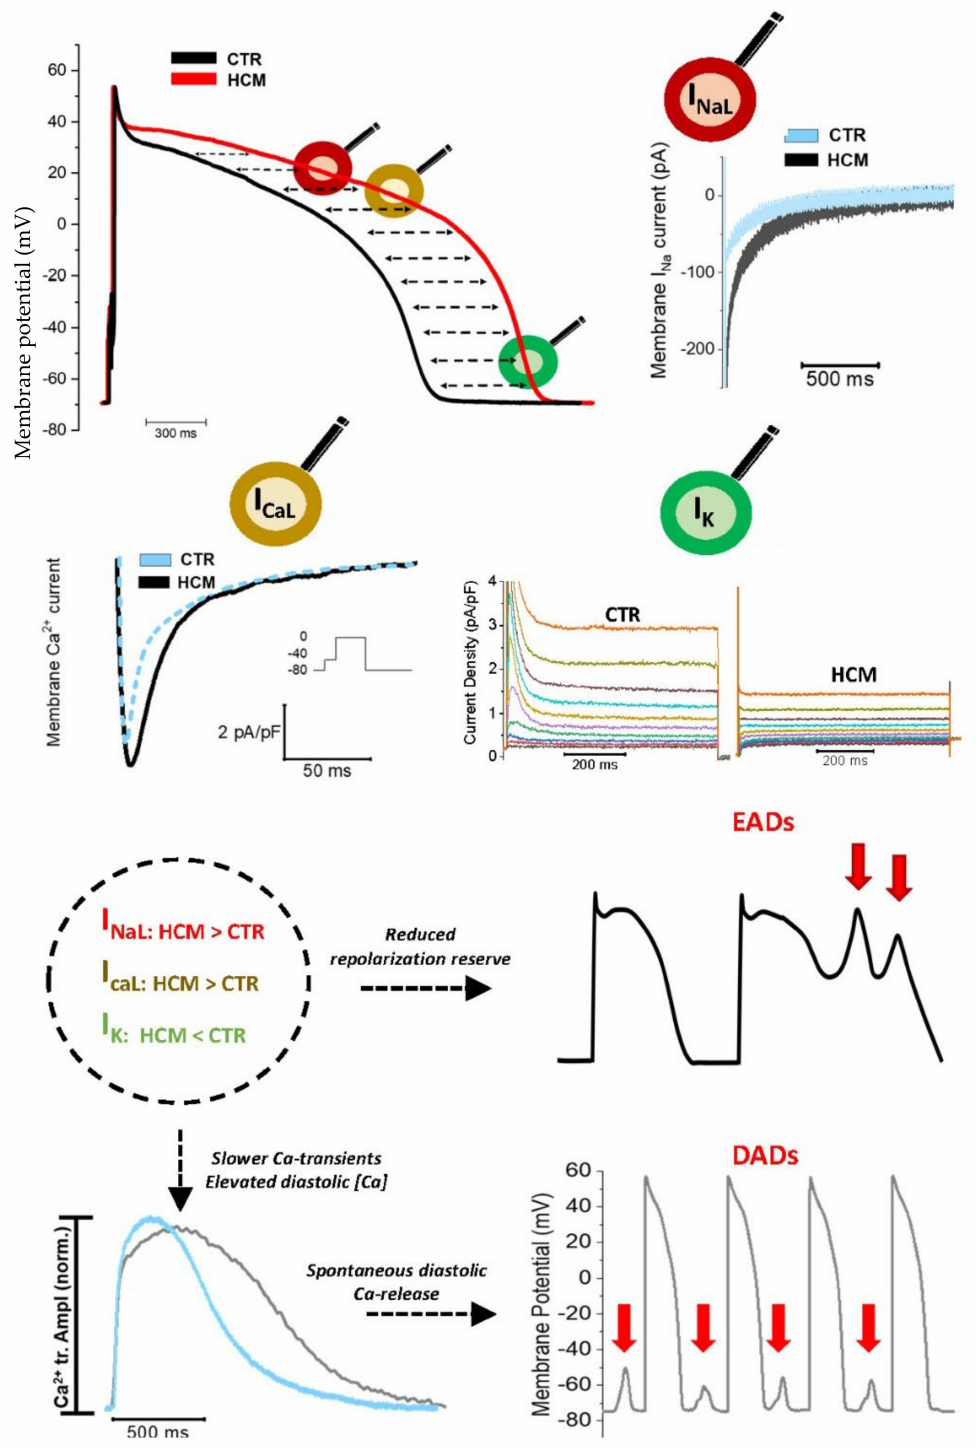
Figure 1. Ion channel remodeling in HCM cardiomyocytes. APD is consistently prolonged in HCM myocytes, due to a combination of increased I NaL , increased I CaL amplitude, slower I CaL inactivation and decreased potassium currents. APD prolongation raises the likelihood of EADs. Accumulation of intracellular calcium and Ca-overload is associated with enhanced spontaneous Ca-release from the SR, thus increasing the probability of calcium waves and DADs. Traces modified from Coppini et al.